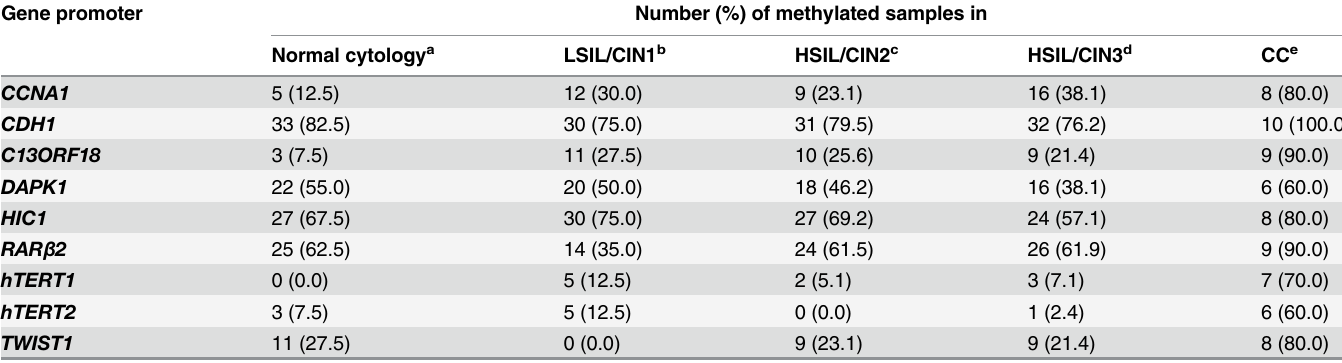
Table 1. Methylation of the host cells gene promoters in the study group (N =